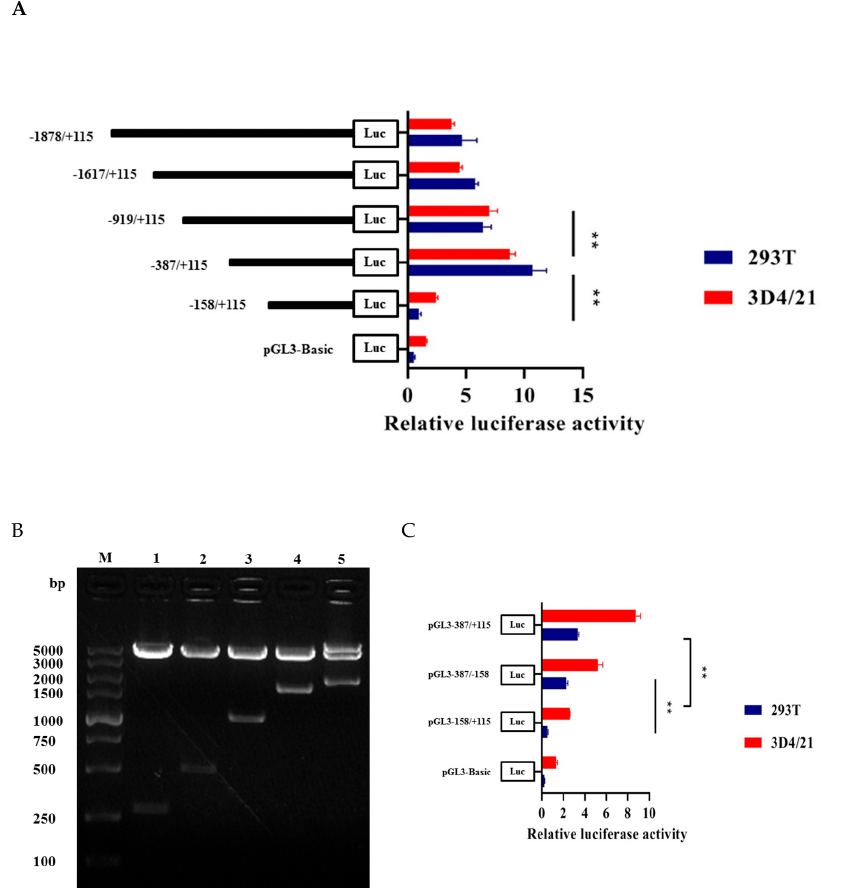
Figure 3 Figure 3. Construction of di ff erent deletion vectors of HMOX1 gene promoter region and luciferase activity